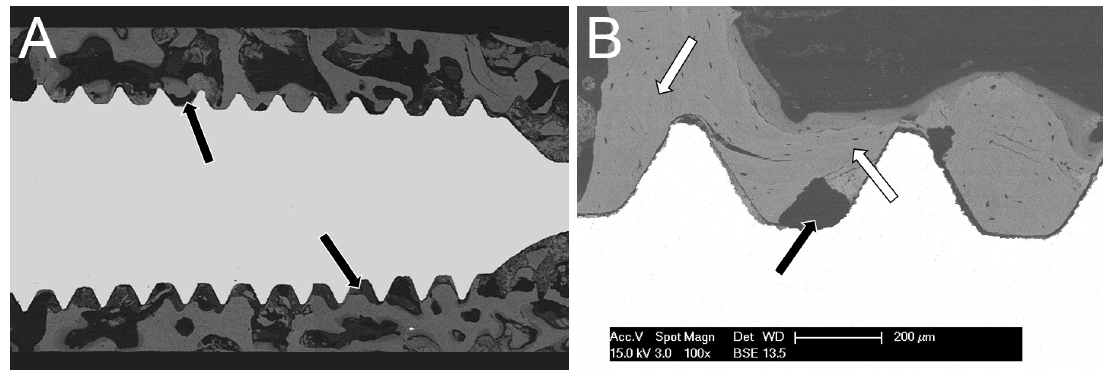
Figure 2. A low magnification (50×) electron micrograph of the implant. Three ridges of the screw are visible across the image, left to right. The voids among the threads are entirely occupied by growing bone tissue (black arrows): the new bone covering the entire fixture confirms the early osseointegration process. On the left, a bone patch crosses the metal ridges (white arrow).